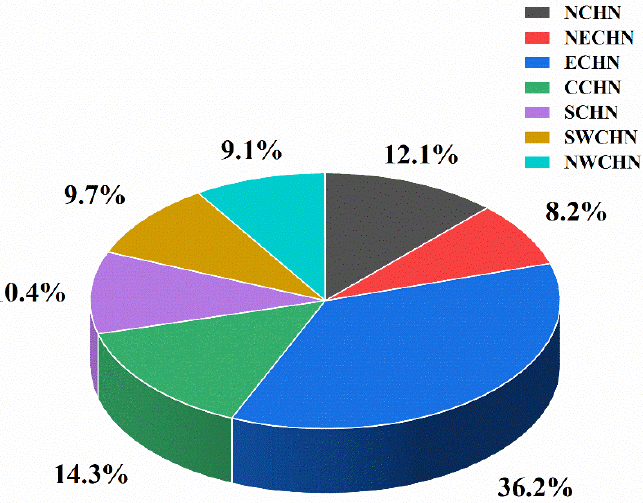
Figure 10. Distribution of cold storage in China.